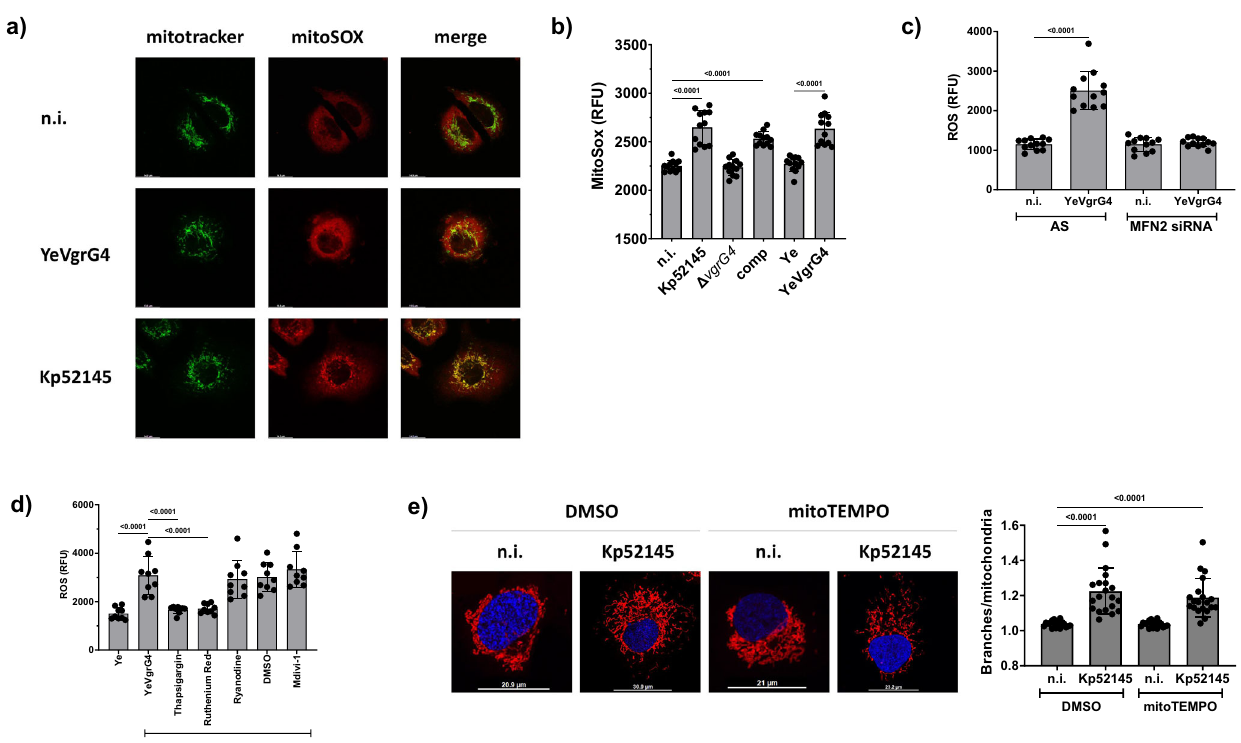
Fig. 5 | VgrG4 induces mitochondrial ROS production. a Mitochondrial ROS (mtROS) was detected in infected A549 cells by confocal microscopy. Cells were treatedwithmitotrackergreen(50 μ M,30min,ingreen),infectedwithYeVgrG4for 90min or with Kp52145 for 3h, and treated with mitoSOX red mitochondrial superoxide indicator (10 µ M for 30min incubated in calcium free HBSS). Fluores- cence was measured ( b ) in A549 cells upon infection with Y. enterocolitica strains for 90min or K. pneumoniae strains for 3h, followed by incubation with mitoSOX (10 µ M incubated in calcium free HBSS for 30min prior to measurement). c To demonstrate that VgrG4 localisation is important for ROS production, 2 ’ ,7 ’ - dichloro fl uorescein (DCF) was used to measure ROS production by A549 cells transfected with MFN2 siRNA or non-silencing (AS) control and infected with